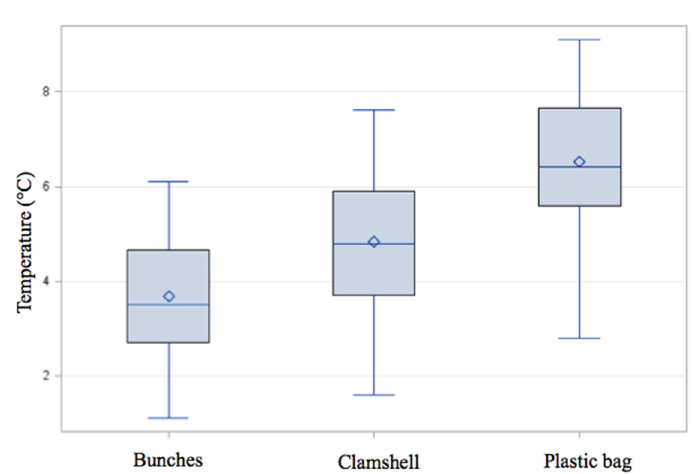
Figure 7. Increases in pulp temperature from the beginning to the end of the six-hour trial inside amaranth stored at ambient temperature in bunches (control), clamshells and plastic bags. Initial temperature at the start of the trial was approximately 19–20